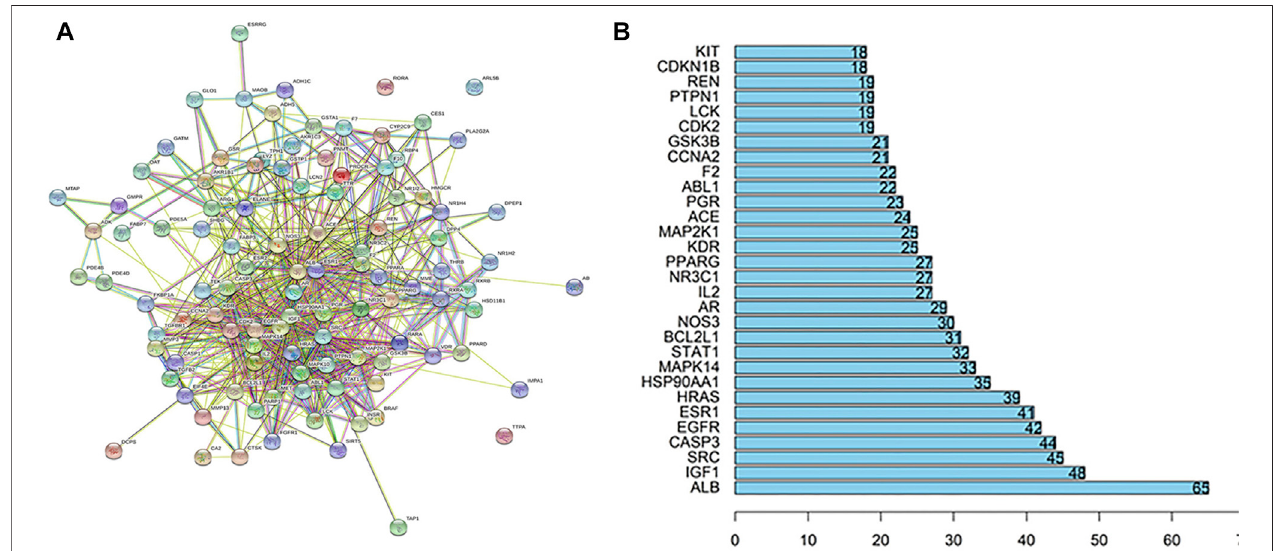
FIGURE 2 | (A) PPI network of XTN against CHD. (B) The top 30 of core proteins in PPI